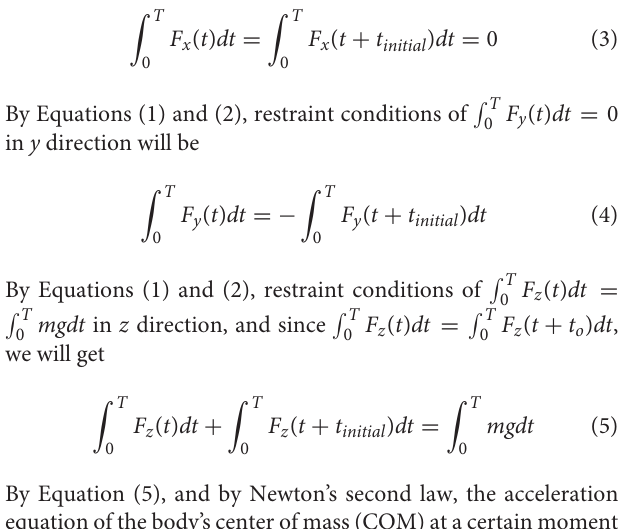
coordinate system respectively, and t a certain moment in a stride